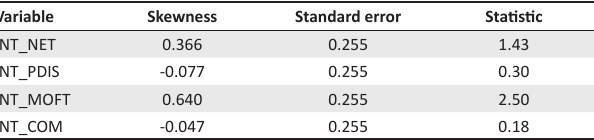
TABLE 5: Skewness of observed variables for the revised Interaction